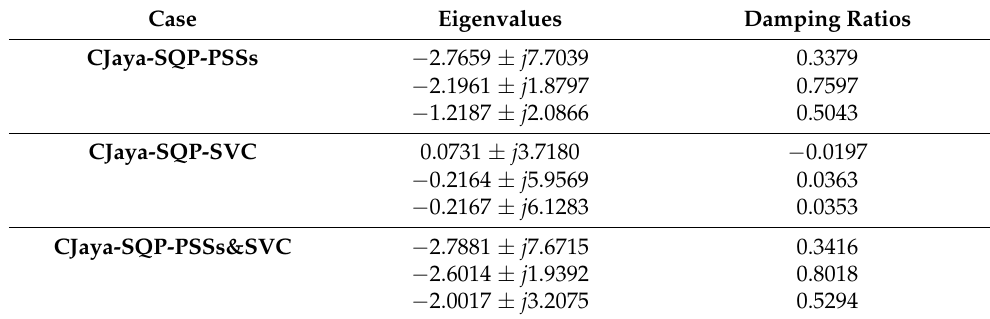
Table 14. Test system electromechanical modes and related damping ratios for different